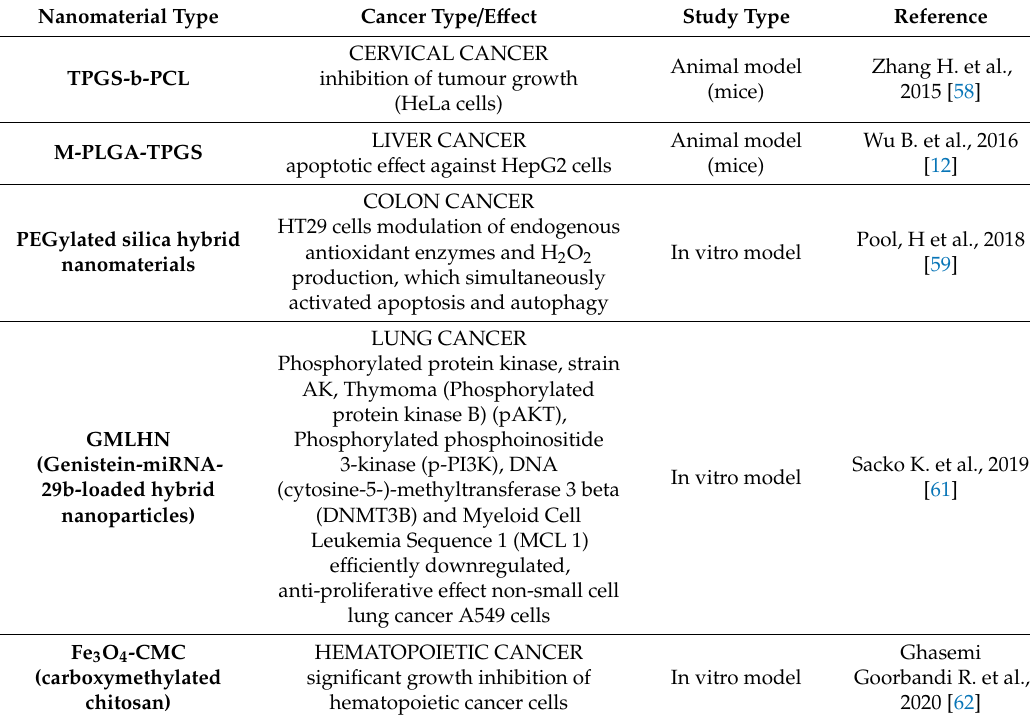
Table 3. Anticancer e ff ect of genistein nanoparticles in in vitro and in vivo